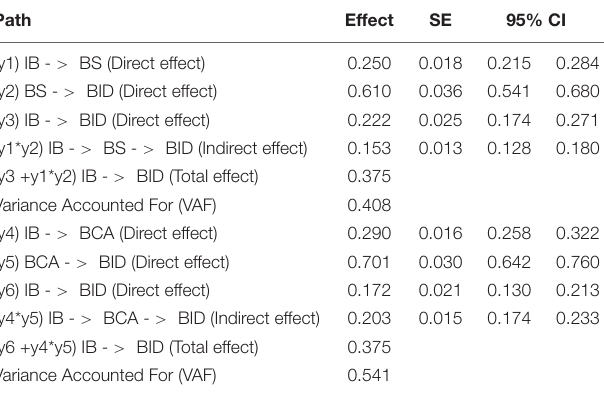
TABLE 7 | Mediation analysis using Sobel test (SPSS syntax) and variance accounted for